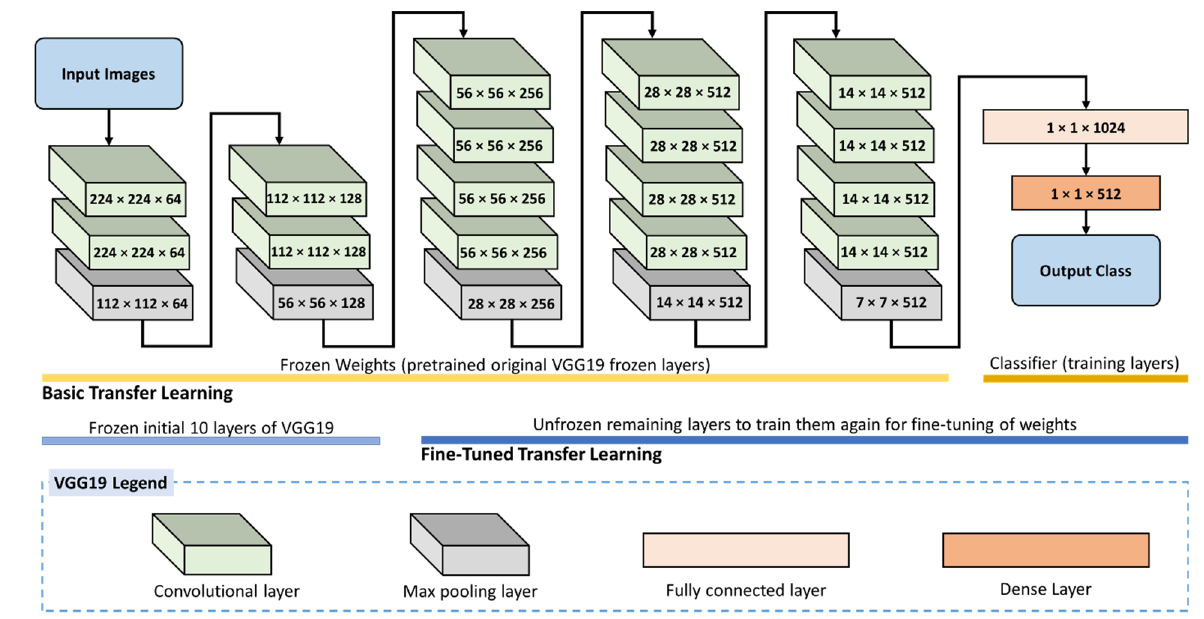
Figure 4. Fine-tuned transfer learning for the VGG19 model for rice leaf disease identification.